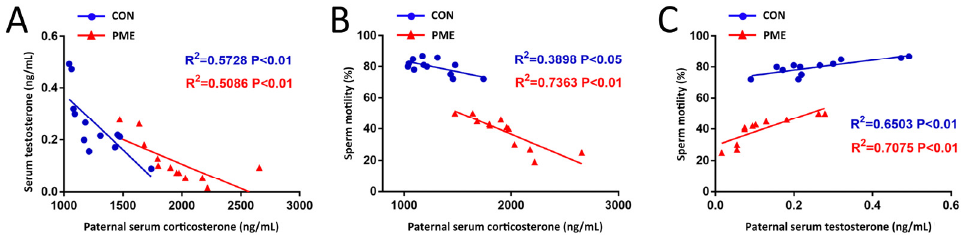
Figure 7. Paternal correlation analyses among serum corticosterone, testosterone levels, and sperm motility in paternal caffeine/nicotine/ethanol exposure rats. ( A ) Correlation between paternal serum corticosterone and testosterone. ( B ) Correlation between paternal serum corticosterone and sperm motility. ( C ) Correlation between paternal serum testosterone and sperm motility. PME, paternal mixed exposure.